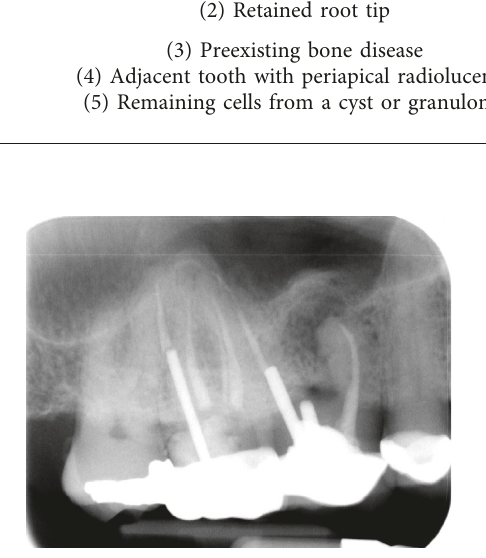
Figure 1: Radiograph of tooth #3 showed periapical radiolucency on the mesial buccal root.